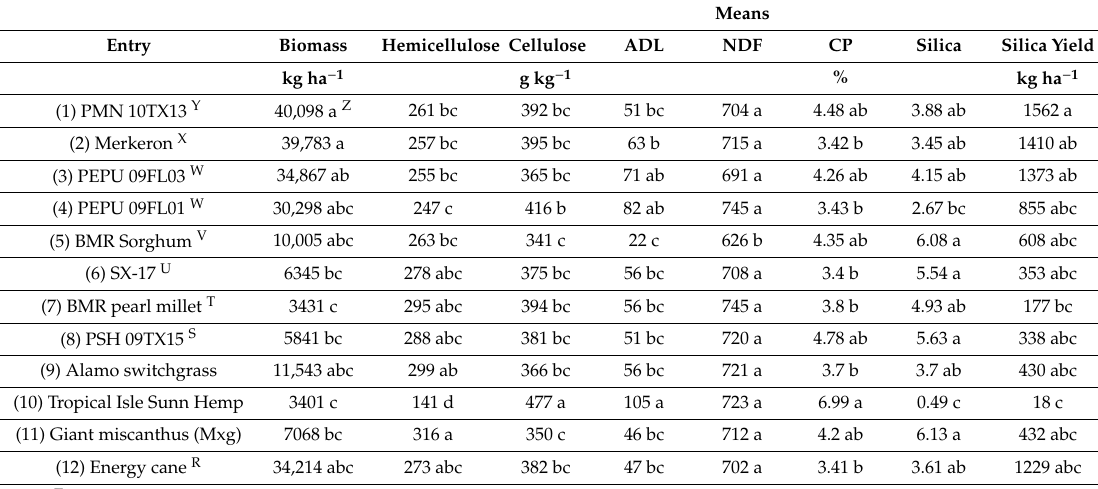
Table 8. Second year Beeville sample traits of biomass yield (kg ha − 1 ) and chemical composition including hemicellulose, cellulose, acid detergent lignin (ADL), neutral detergent fiber (NDF) (g kg − 1 biomass), crude protein (CP) (%), silica (%), and silica yield (kg ha − 1 ). Means Entry Biomass Hemicellulose Cellulose ADL NDF CP Silica Silica Yield